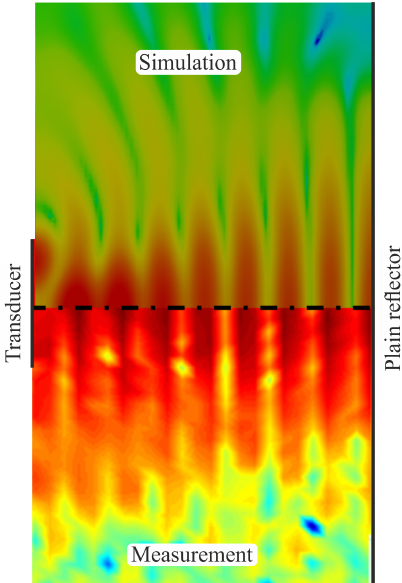
Figure 12. Comparison of simulated and measured field patterns for standing wave system with plain reflector at a distance of L = 4 λ ; sound pressure (model) and virtual velocity (experiment) are scaled logarithmically; f = 21.4 kHz; ˆ x = 19 µ m.